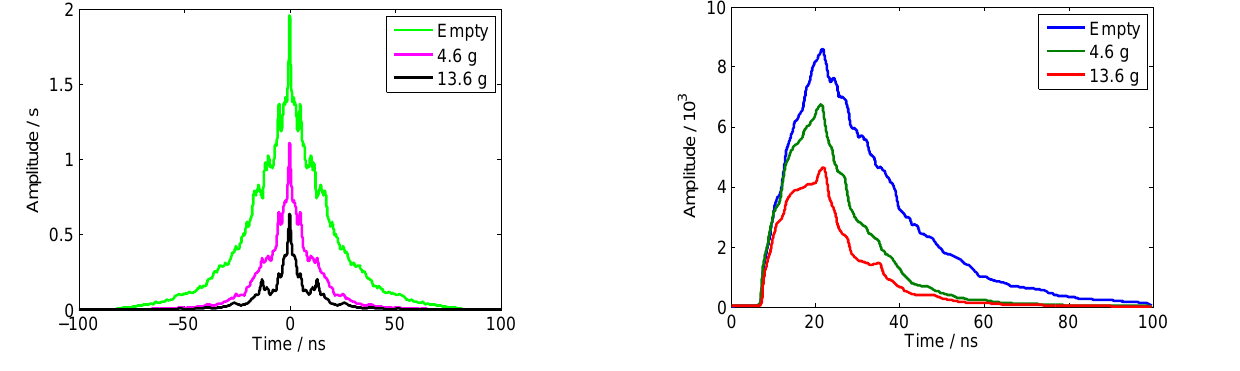
Figure 7. Auto-correlation functions of the envelopes shown in Fig. 5.